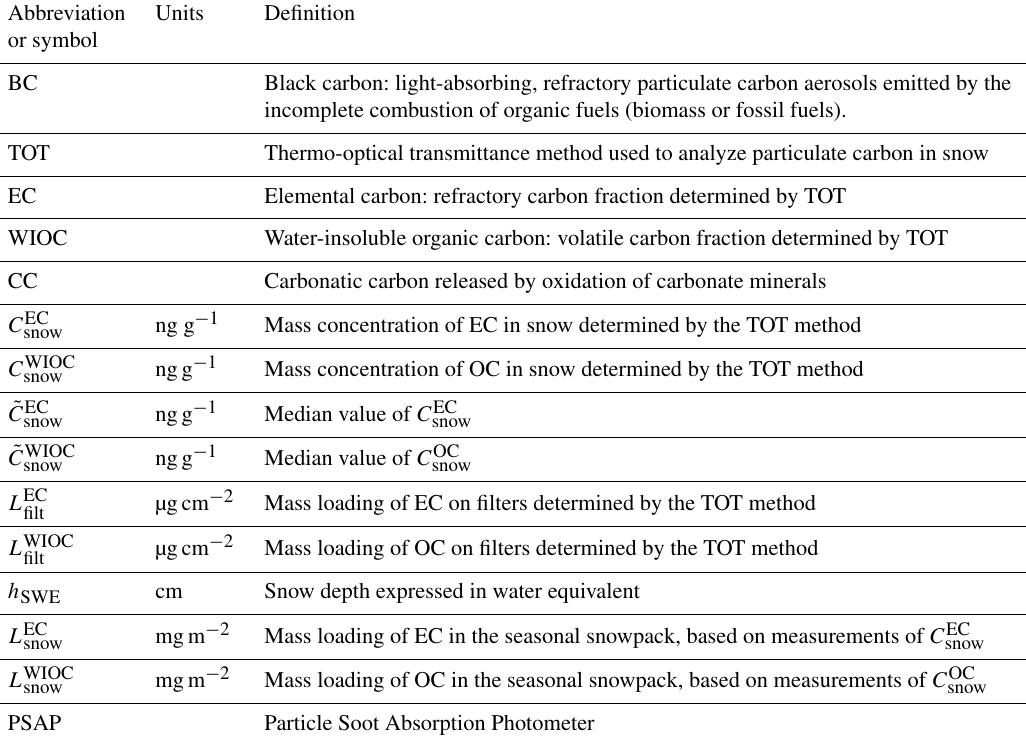
Table 1. Main symbols and abbreviations used in this paper. The various terms for black carbon (BC, EC) are as defined in Petzold et al.